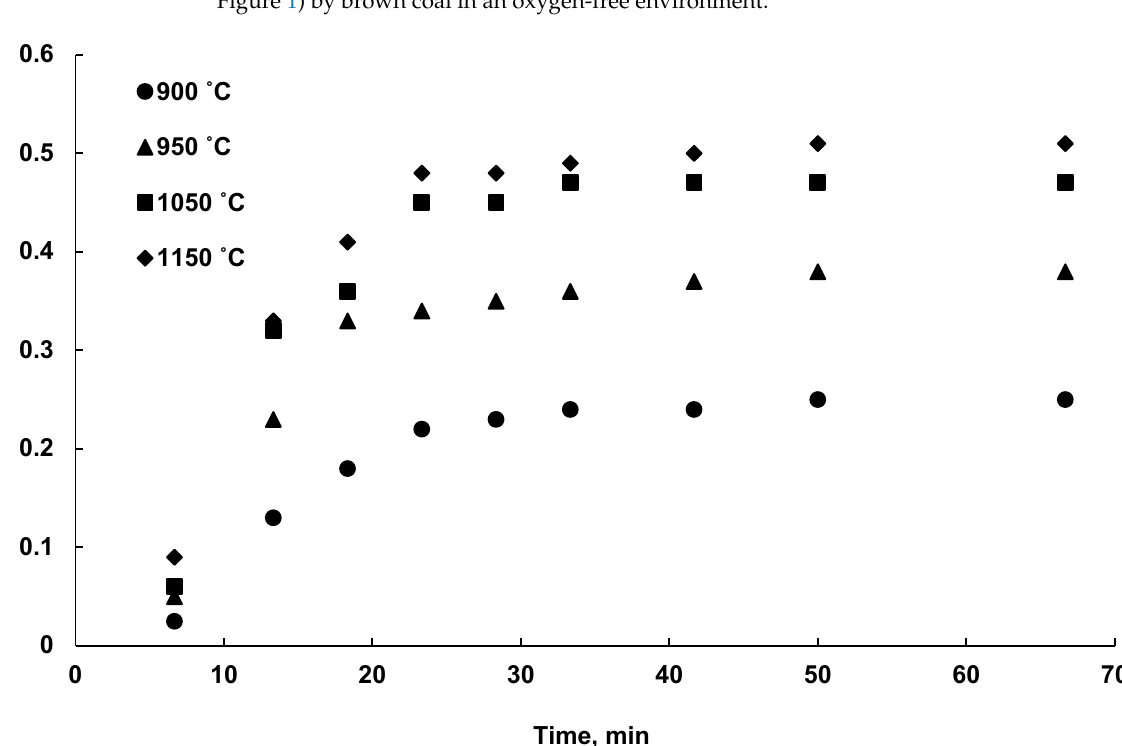
Figure 6. Conversion-time plots for the reduction of barite compacted samples (zone C; see Figure 1) with brown coal.